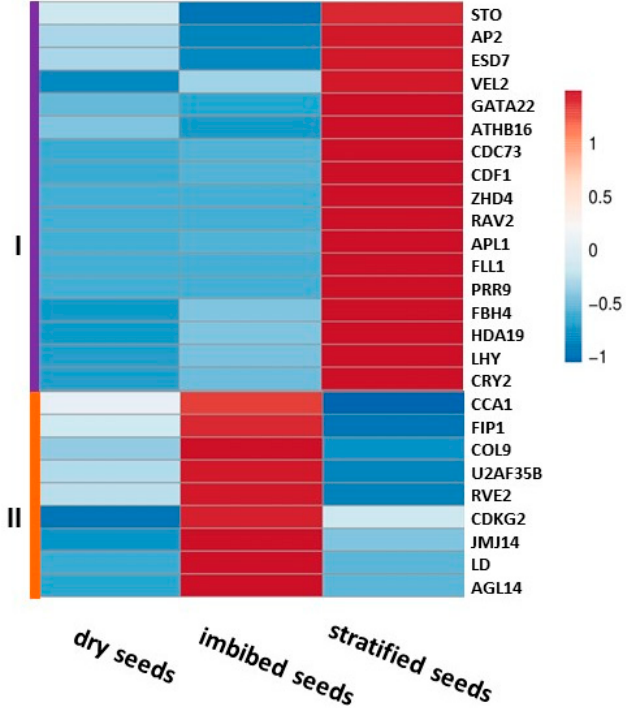
Figure 8. Hierarchical cluster analysis of the meristem identity genes’ expression patterns in dry, imbibed and stratified garlic seeds. Unit variance scaling is applied to the FPKM (fragments per kilobase of transcript per million mapped reads) expression values. Genes are clustered using Pearson correlation distance and average linkage; main clusters are shown by colors and Roman numerals.